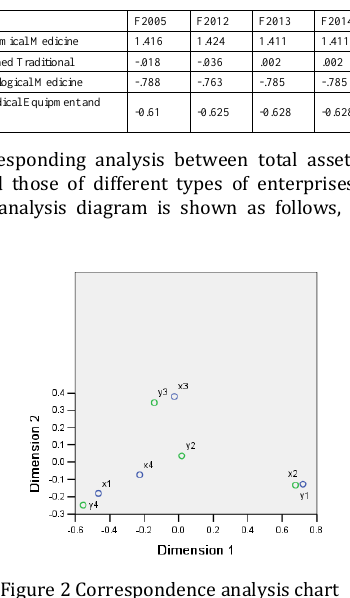
Figure 2 Correspondence analysis